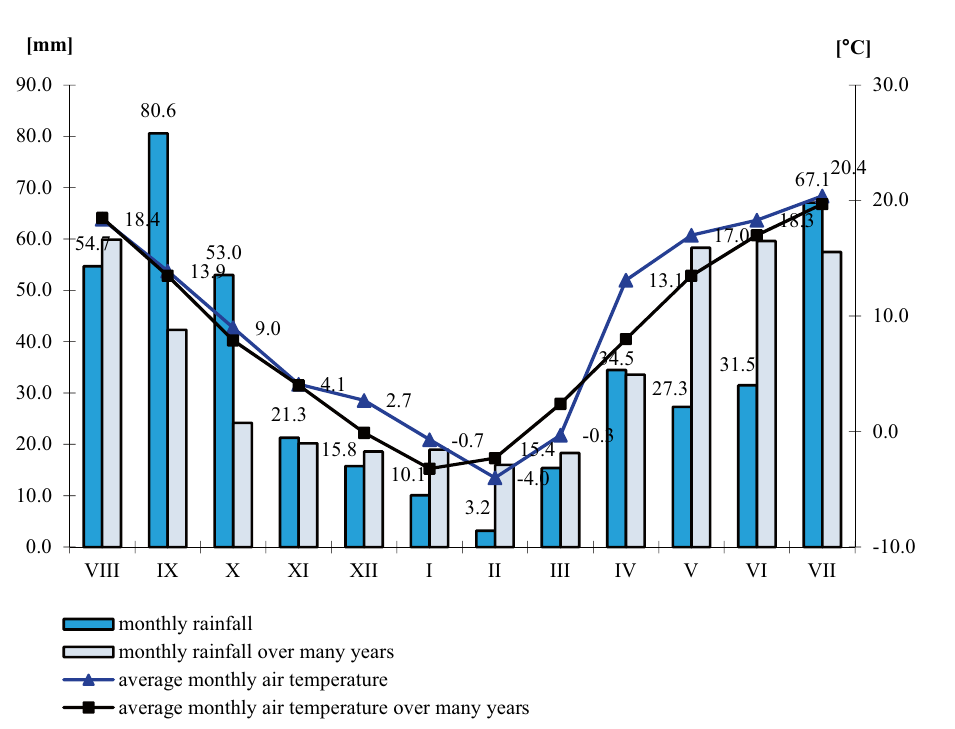
Figure 3. Monthly rainfall totals and average air temperature during the growing season 2017–2018 in RSD Zawady of many years